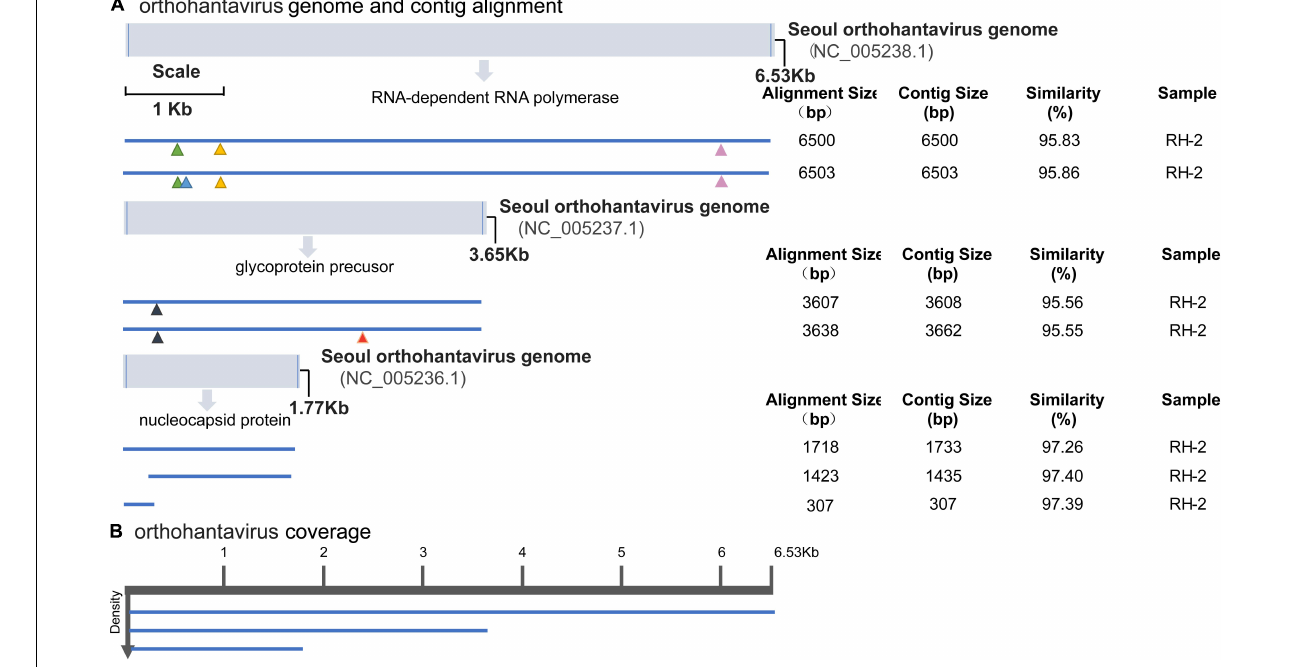
Frontiers in Microbiology |